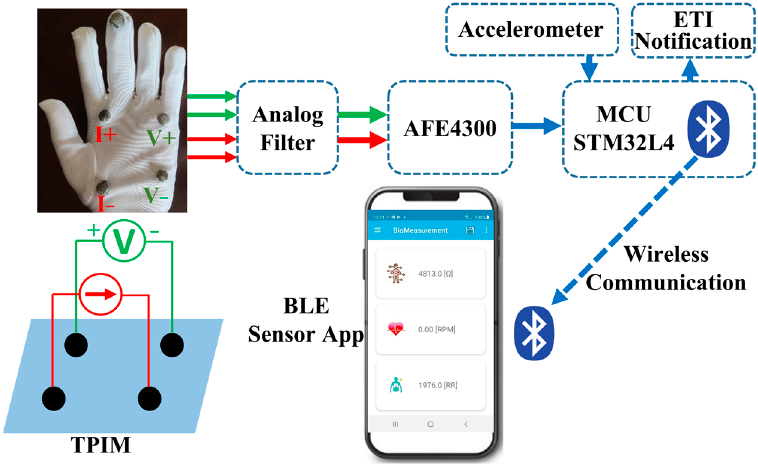
Figure 10. Proposed RR monitoring system block diagram.